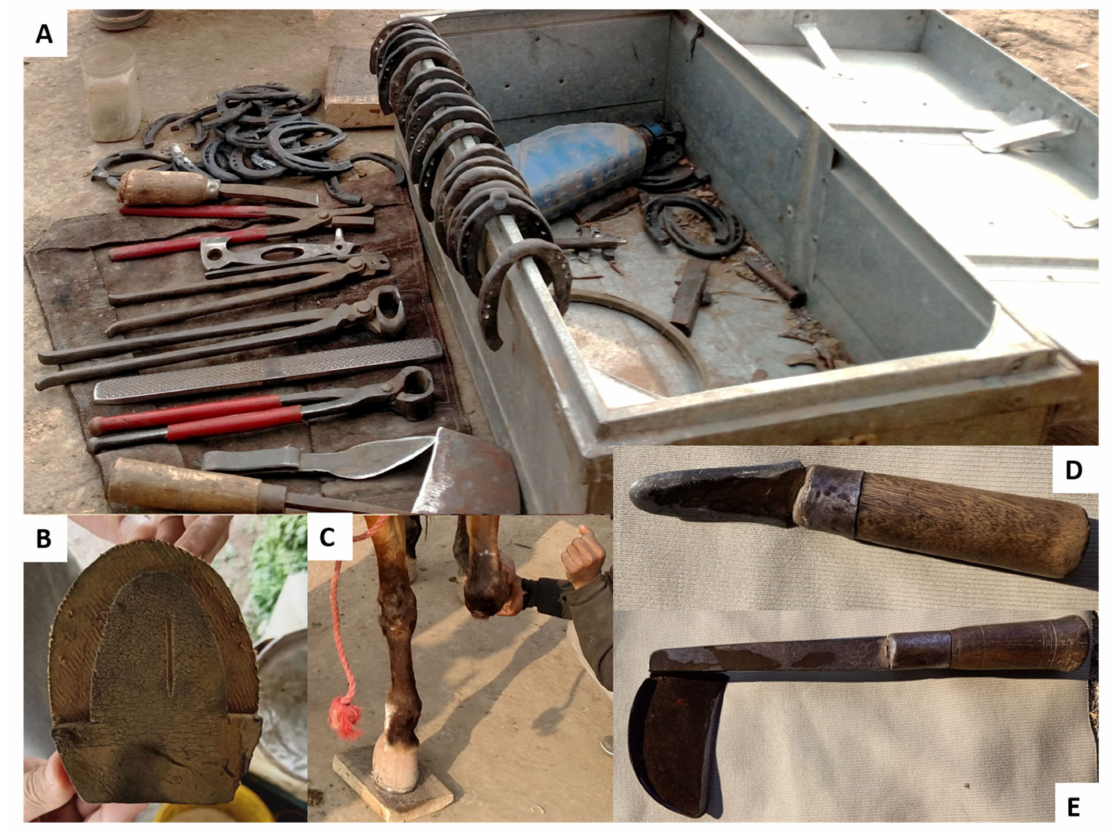
Figure 1. A typical farrier workstation ( A ) with examples of tools and iron shoes. ( B ) Rubber shoe insert ( C ) Plank being used to check hoof balance ( D ) Hoof knife ( E ) ‘Traditional’ hoof